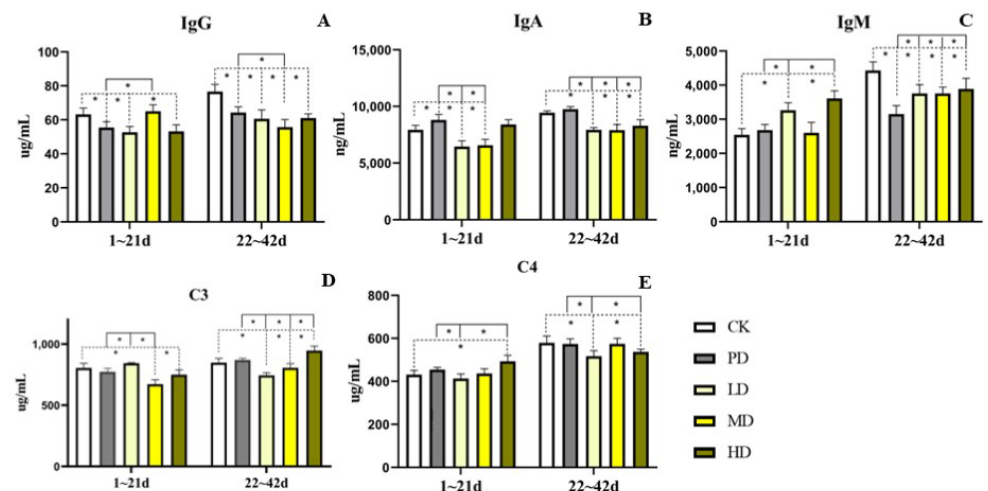
Figure 5. Effects of the fruit extract of K. coccinea on immunoglobulin levels in white-feather broilers ( A ): IgG (Immunoglobulin G); ( B ): IgA (Immunoglobulin A); ( C ):IgM (Immunoglobulin M); ( D ): C3 (Complement 3); ( E ): C4 (Complement 4); Note: Dotted line: compare with CK group; Solid line: compare with PD group; * indicate significant differences between groups according to the Tukey test; Supplementary Materials Table S5.